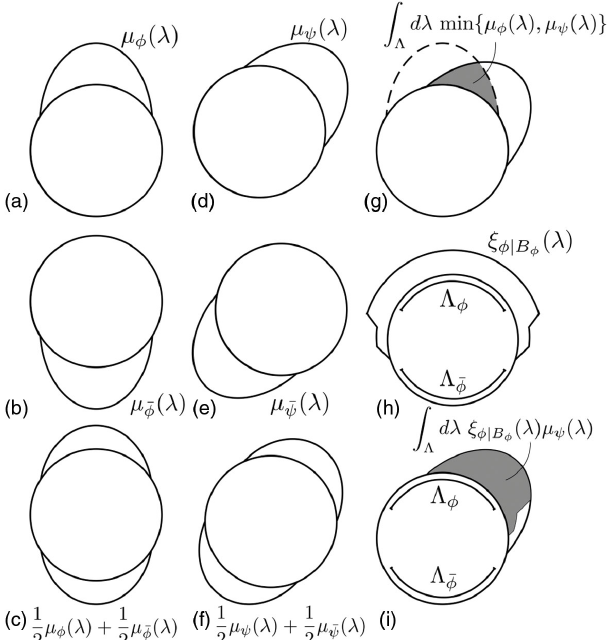
FIG. 3. In a contextual model of a MESD scenario: (a) – (f) epistemic states, (g) classical overlap between μ ϕ ð λ Þ and μ ψ ð λ Þ , (h) response function ξ ϕ ð λ Þ , with indication of Λ ϕ ≡ j B ϕ supp ½ μ ϕ ð λ Þ(cid:2) and Λ ¯ ϕ ≡ supp ½ μ ¯ ϕ ð λ Þ(cid:2) , (i) confusability defined by ξ λ Þ , also with indication of Λ Λ ¯ ϕ j B ϕ ð ϕ and ϕ